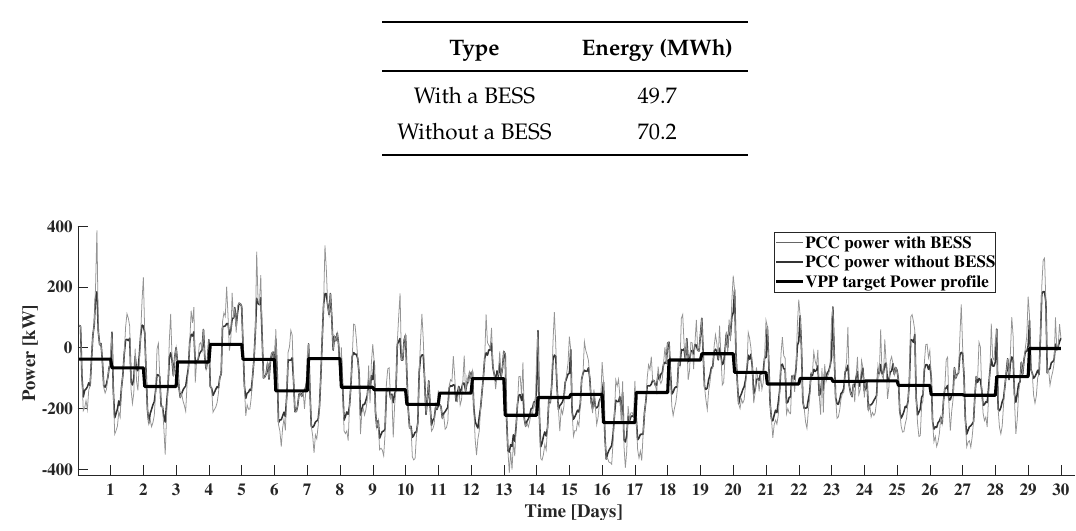
Table 2. Comparison of monthly energy fluctuations without a BESS.